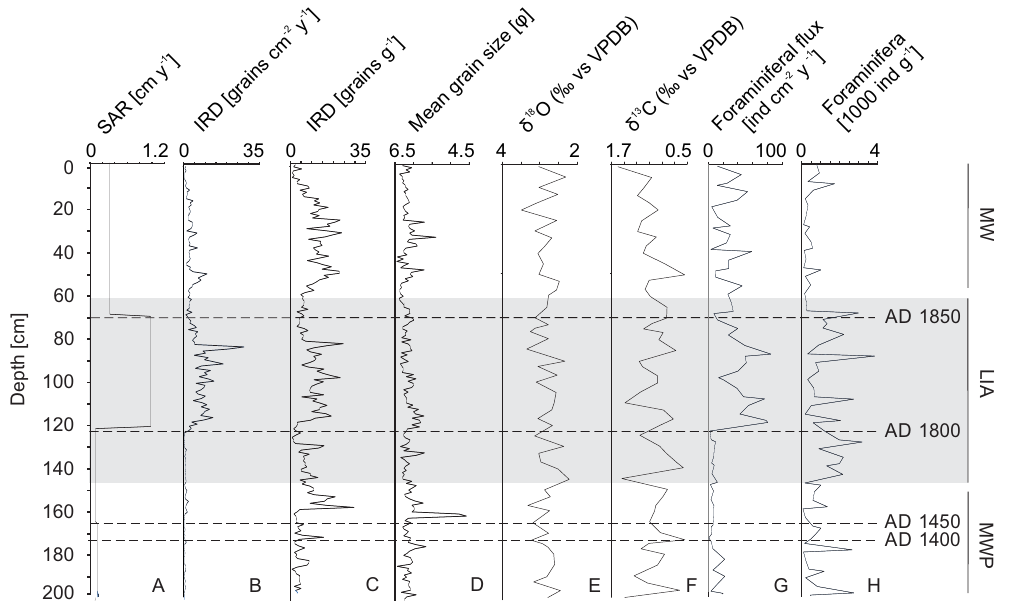
Figure 3. Sediment accumulation rate (a) , IRD delivery, expressed as IRD flux (b) and number of IRD grains per gram of sediment (c) , mean grain size (d) , stable oxygen (e) and carbon (f) isotopes, flux of total fossil foraminifera (g) and number of foraminifera per gram of sediment (h) . MWP: Medieval Warm Period; LIA: Little Ice Age; MW: modern warming. The time ranges of the MWP, LIA and MW are presented after Majewski et al.